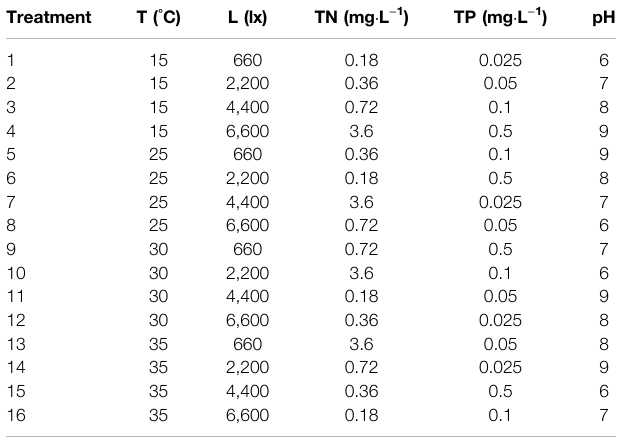
TABLE 2 | The orthogonal test program.